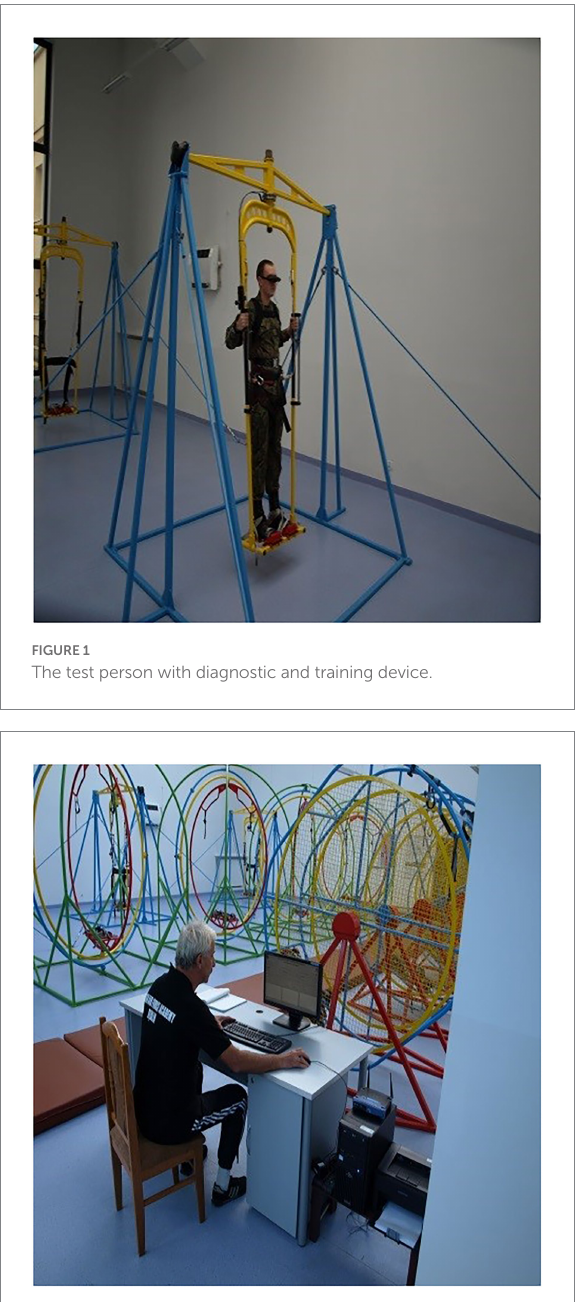
FIGURE 2 Operator’s